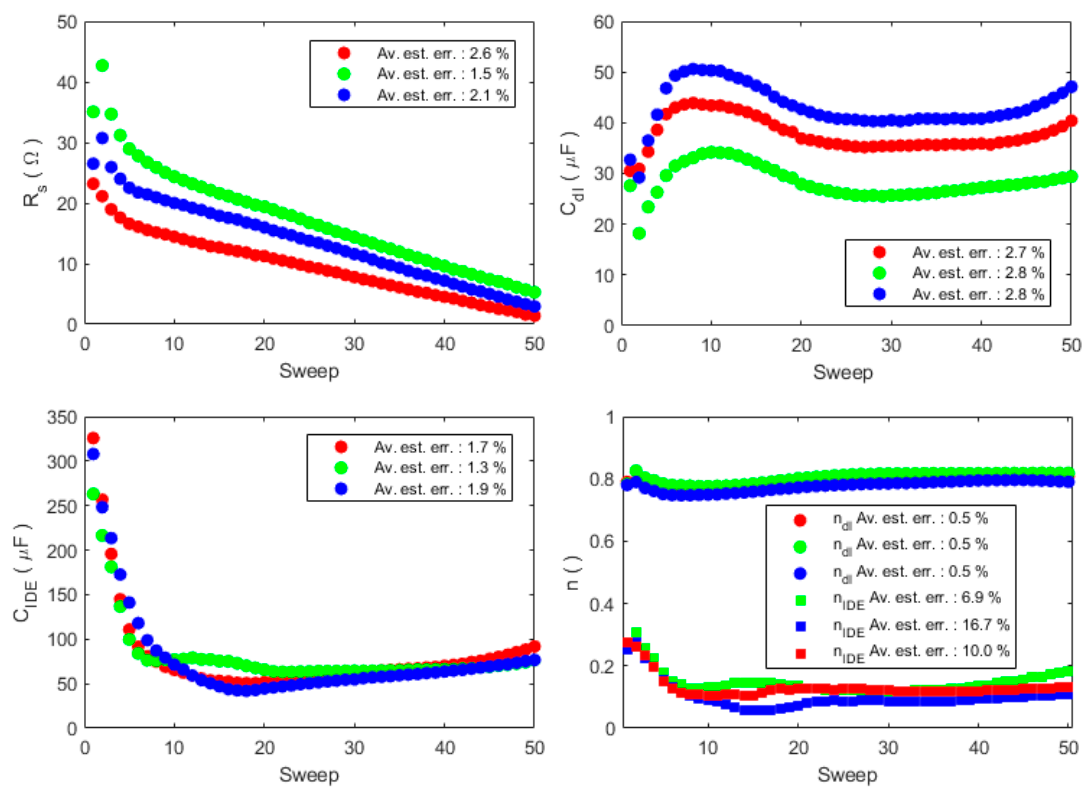
Figure 8. Values of the parameters of the electrical equivalent model of Figure 1c for the 50 repeated EIS measurements in 10 mM PBS with 100 µ m wide electrodes and 2 mm long windows IDE EIS measurements in 10 mM PBS with 100 µm wide electrodes and 2 mm long windows IDE sensors.